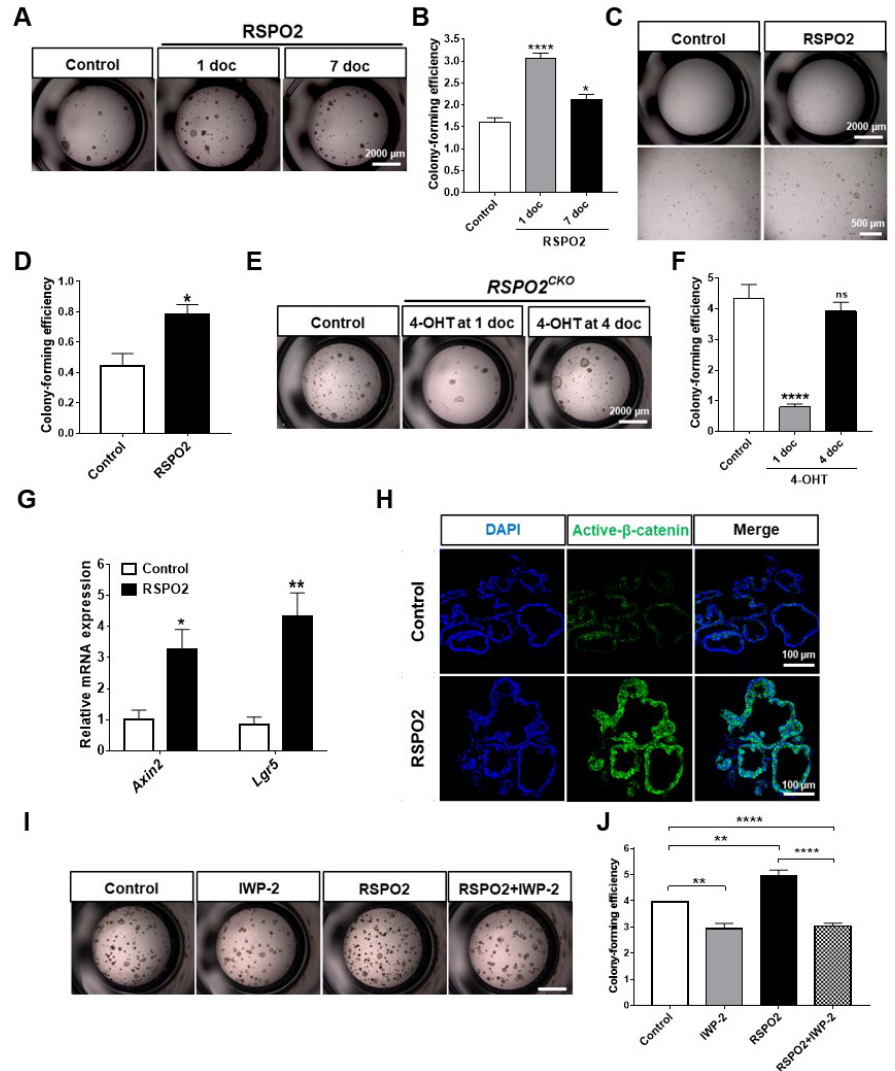
Figure 3. RSPO2 supports the colony formation of club cells in ex vivo 3D organoid culture through the activation of endogenous WNT/ β -catenin signaling. ( A , B ) Bright-field images and colony-forming efficiency of club cells in the 3D organoid culture showing the effect of RSPO2 treatment (200 ng/mL). RSPO2 was administered from day 1 of culture (1 doc) or day 7 of organoid culture (7 doc). ( C , D ) Bright-field images and colony-forming efficiency of club cells in a fibroblast-free, FGF10/HGF supplemented 3D organoid culture. RSPO2 (200 ng/mL) was added from 1 doc for 7 days. ( E , F ) Bright-field images and colony-forming efficiency of Rspo2 CKO club cells in the organoid culture. ( G ) RSPO2 (200 ng/mL) upregulated the expression of two WNT/ β -Catenin downstream target genes, Axin2 and Lgr5 , in club cell-derived organoids, as determined by qRT-PCR analysis. ( H ) Immunofluorescence staining of active β -Catenin (unphosphorylated form) after RSPO2 treatment in club cell-derived organoids. Cell nuclei were counterstained with DAPI. ( I , J ) Bright-field images and colony-forming efficiency of club cells showing the effect of WNT protein secretion blocker, IWP-2 (5 µ M), on the organoid culture (Scale bar, 2000 µ m). All organoids were harvested